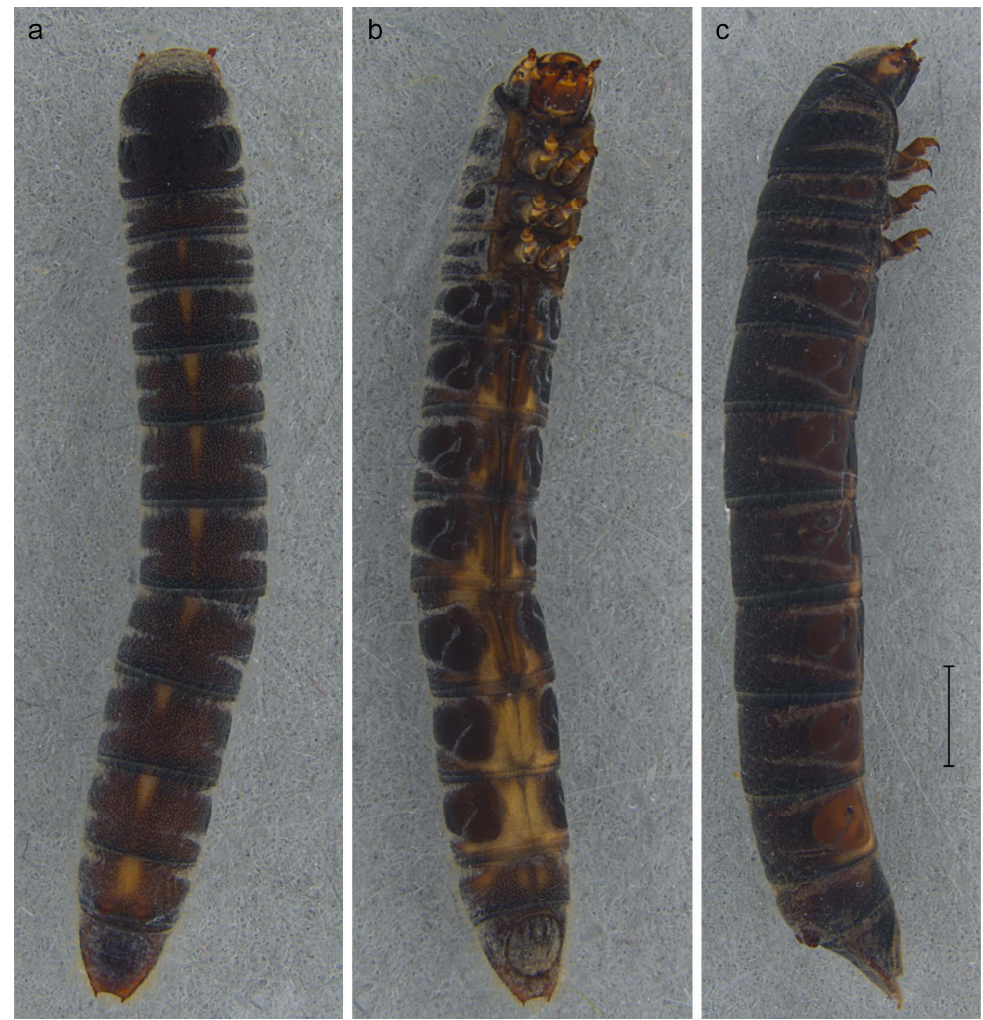
Figure 3. Araeopidius monachus (LeConte, 1874), larva. ( a ) Dorsal view; ( b ) ventral view; ( c ) right lateral view. Scale bar = 1.0 mm.